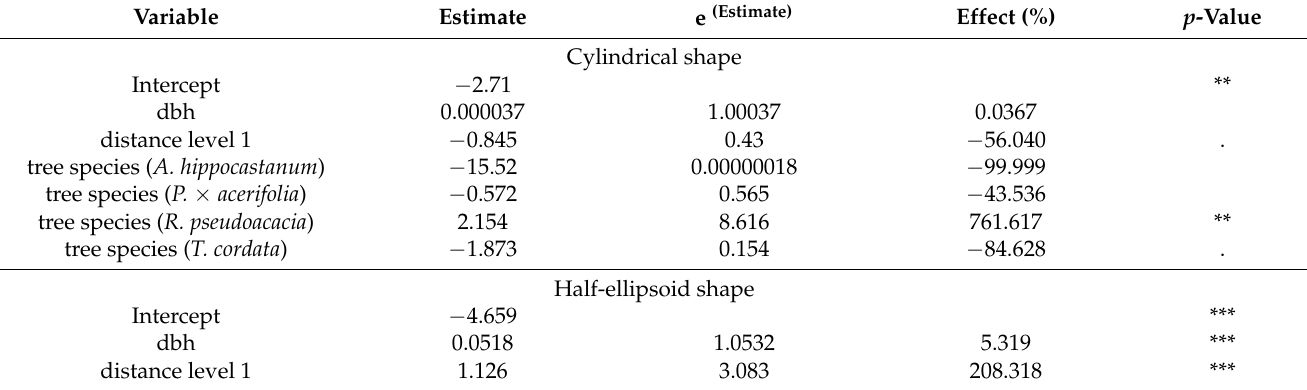
Table 6. Dependency of the crown shape depending on tree species, dbh and distance level to ob- jects. The used formula is (glm (crown shape)~dbh + as. factor (distance level) + as. factor (tree spe- cies)). The distance level 1 refers to the probability in comparison to the distance level with index 0. The reference tree species is A. platanoides , to which the tree species variable refers. p -value signifi- cance follows the RStudio output with “***” for p < 0.001, “**” for p < 0.01, “*” for p < 0.1 and “.” for p < 0.1.